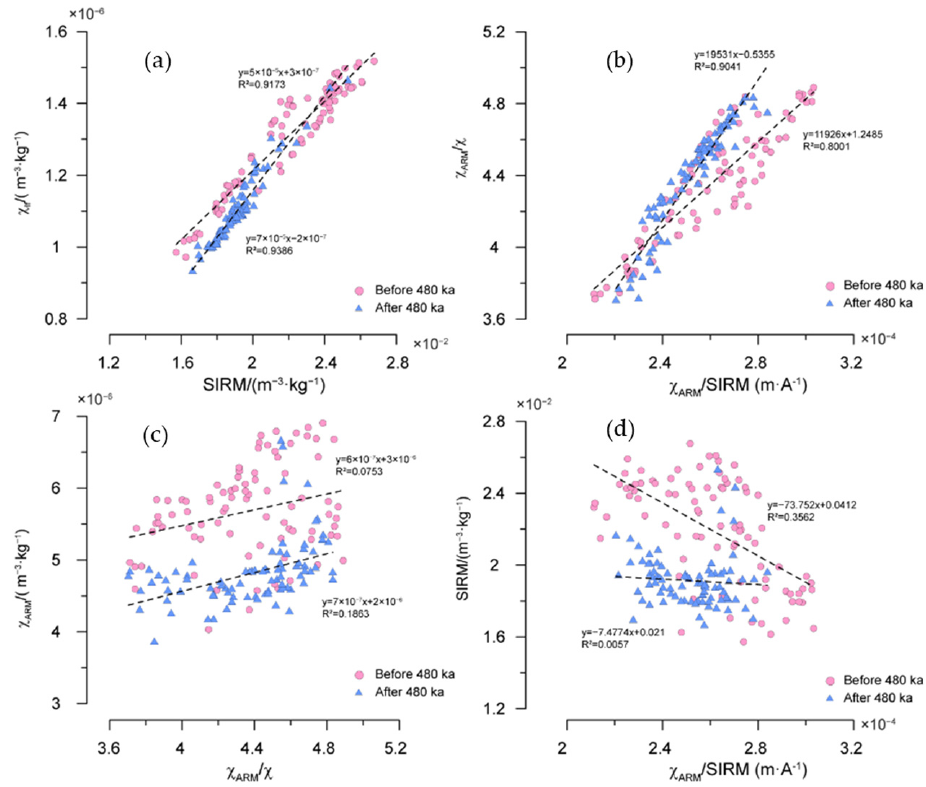
Figure 4. Relationships between magnetic parameters of Core I8. ( a ), χ lf vs. SIRM; ( b ), χ ARM / χ vs. χ ARM /SIRM; ( c ), χ ARM vs. χ ARM / χ ; ( d ), SIRM vs. χ ARM /SIRM. The scatter plots of magnetic parameters before (pink circle) and after 480 ka (blue triangle) are presented. Next to them are the regression equation and correlation coefficient of two stages.